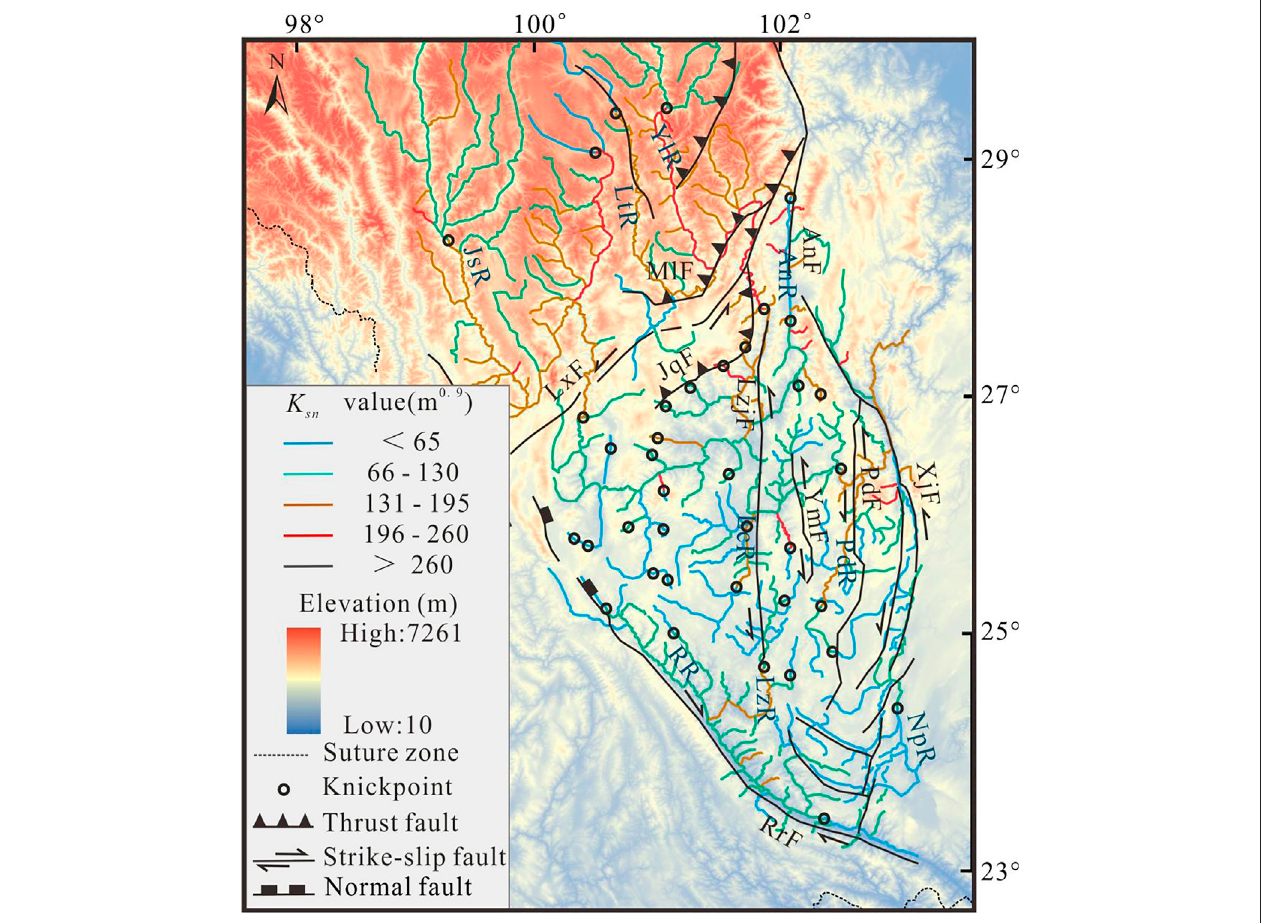
FIGURE 3 | Spatial pattern of the normalized channel steepness across the Central Yunnan subblock. AnF , Anninghe Fault; LxF , Lijiang – Xiaojinhe Fault; MlF , Muli Fault; JqF , Jinhe – Qinghe Fault; LzjF , Lvzhijiang Fault; YmF , Yimen Fault; PdF , Pudu Fault; XjF , Xiaojiang Fault; RrF , Red River Fault; AnR , Anning River; LcR , Longchuan River; PuR , Pudu River; LzR , Lvzhi River; NpR , Nanpan River; RrR , Red River; JsR , Jinsha River; LtR , Litang River.